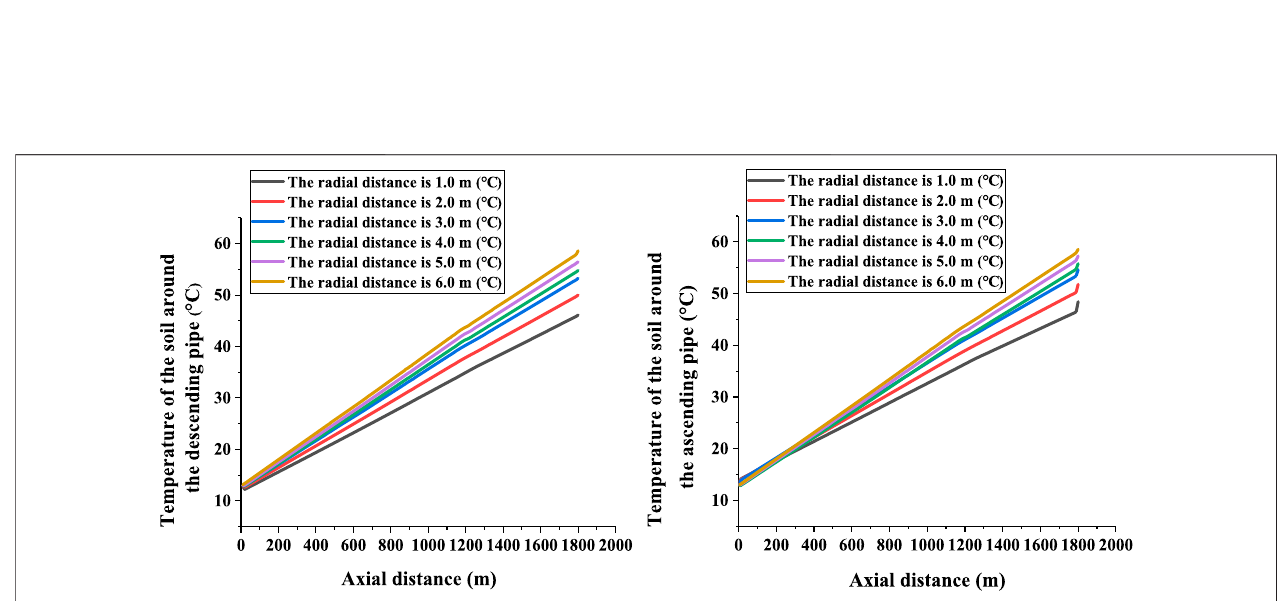
FIGURE 8 | Axial distribution of the soil temperature around the vertical pipe.